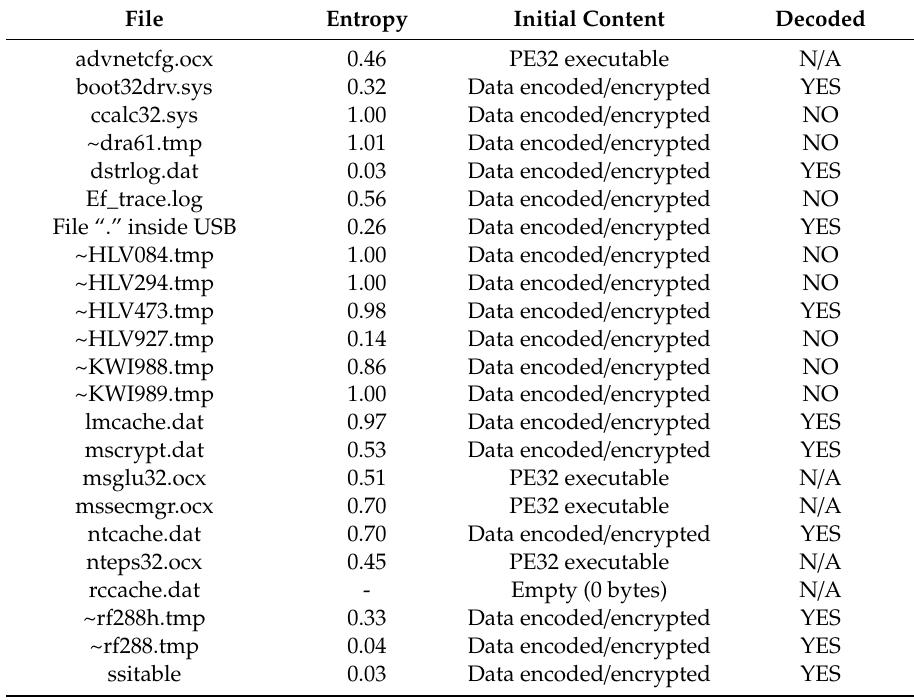
Table 10. Files created by